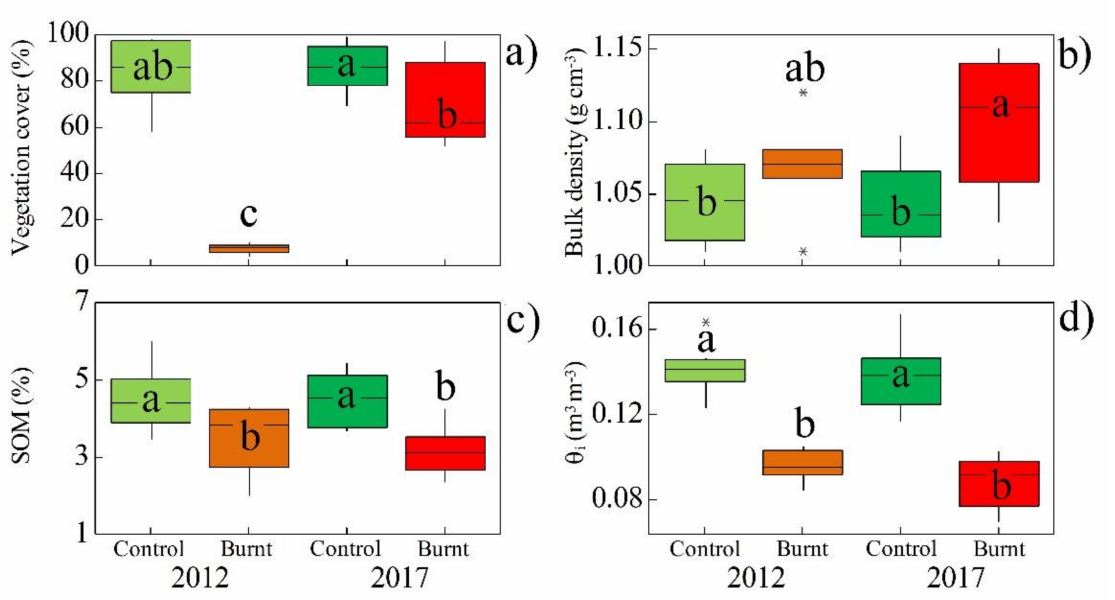
Figure 3. Box plots of the ( a ) vegetation cover (%), ( b ) soil bulk density (g · cm − 3 ), ( c ) soil organic matter, (SOM) (%), and ( d ) initial volumetric soil water content, θ i (m 3 · m − 3 ), for the four scenarios. Asterisks denote outliers. Different letters represent significant differences at p <